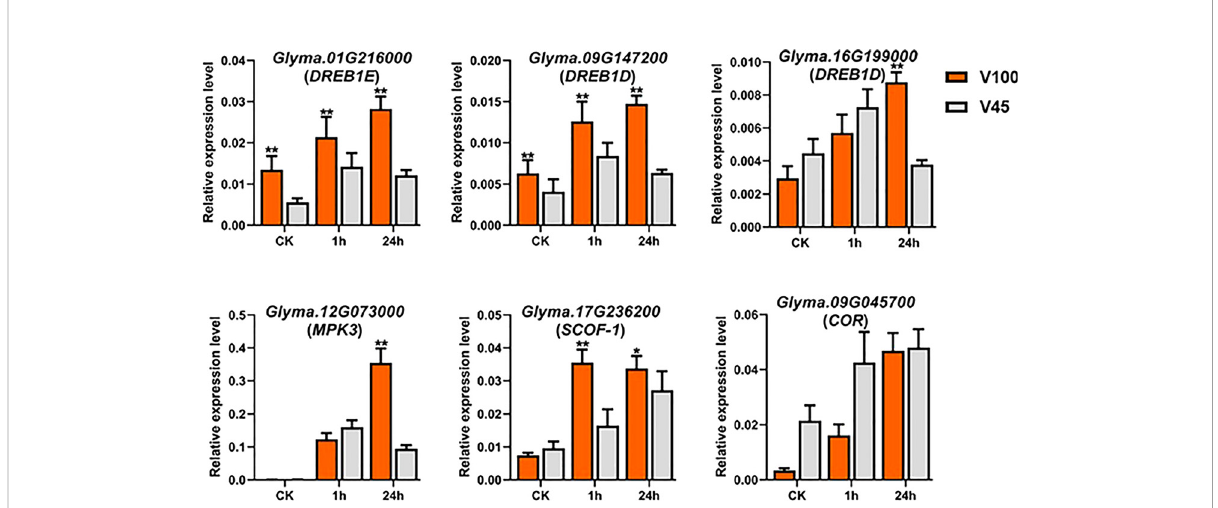
FIGURE 10 qRT-PCR expression analysis of cold related marker genes in V100 and V45. The time course qRT-PCR was performed to evaluate the expression differences of cold marker genes in cold tolerant V100 and cold sensitive V45. Data was analyzed with the Statistix 8.1. The ** and * asterisks indicate the signi fi cant differences at p-value <0.01 and p-value <0.05,